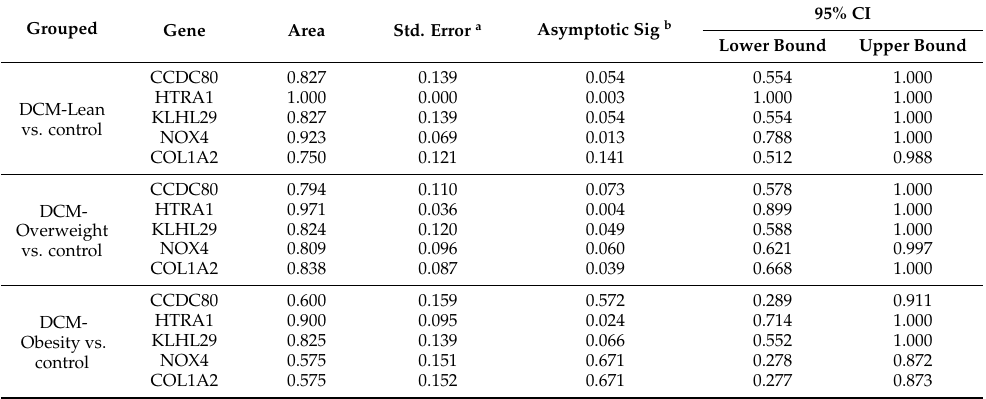
Figure 5. GSE19303 was used to verify the expression levels of key genes in each group. ( A ) The boxplot of key gene expression in DCM and control group. ( B ) The baseline samples in GSE19303 divided into six groups by DCM and BMI. ( C ) The boxplot of key gene expression before and after IgA/IgG in 13 nonresponders. ( D ) The boxplot of key gene expression before and after IgA/IgG in 20 responders. * p < 0.05, ** p < 0.01, **** p < 0.0001. Table 1. Area under the curves